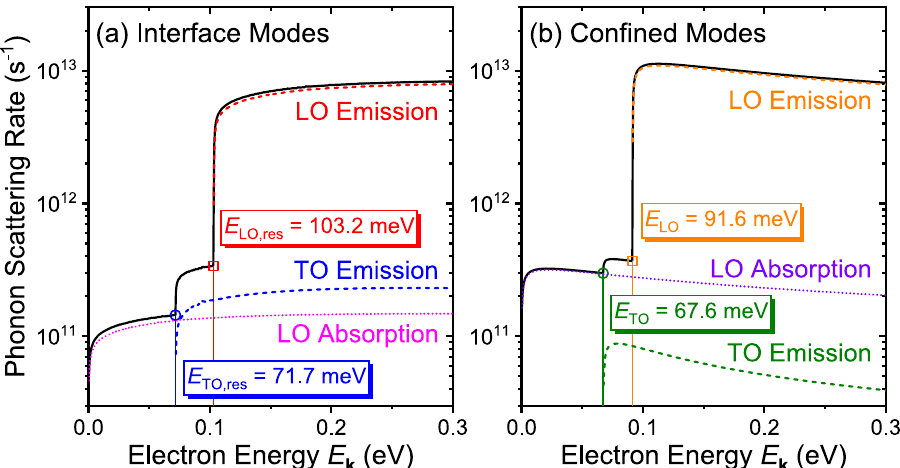
Figure 4. ( a ) Interface and ( b ) confined mode phonon scattering rates are calculated and plotted as a function of electron energy. For both modes, the total interface phonon scattering rate combining all phonon modes (including the TO absorption scattering rate) is shown as the black solid line. The droplines with symbols are shown to indicate the threshold energies of TO emission and LO emission scattering. For interface mode scattering, these energies correspond to the TO and LO interface phonon resonant frequency energies ħ ω TO,res = 71.7 meV and ħ ω LO,res = 103.2 meV, respectively. For confined mode scattering, the threshold energies are at the vicinity (but not a complete match) of the TO and LO phonon energies of GaN, ħ ω 1z = 65.8 meV and ħ ω 1Lt = 91.9 meV,